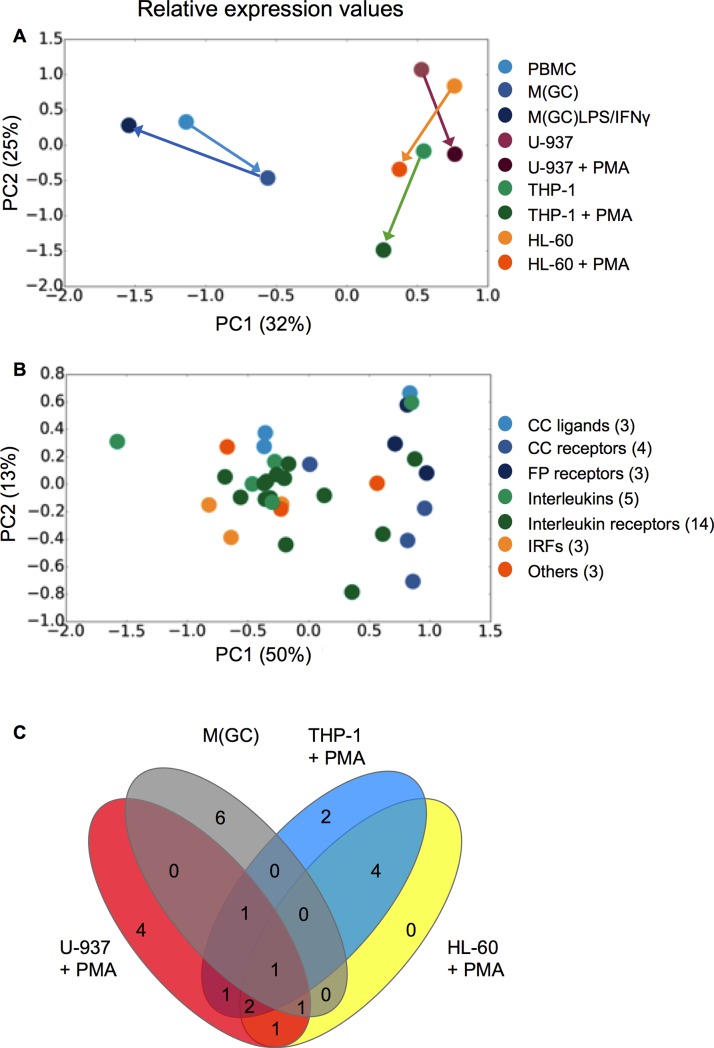
Principal component analysis (PCA) of the mean relative expression values (n = 3–10) grouped by either cell type (A) or gene family (B) shown in Fig 1 and (C) Venn diagram using the relative expression values of genes displaying a significant up-regulation or down-regulation in expression, after GM-CSF or PMA treatment for PBMCs, U-937, THP-1, and HL-60 cells.Connecting arrows in the PCA analysis represent changes from undifferentiated to differentiated state. Data used to generate (C) are summarized in Table 1.